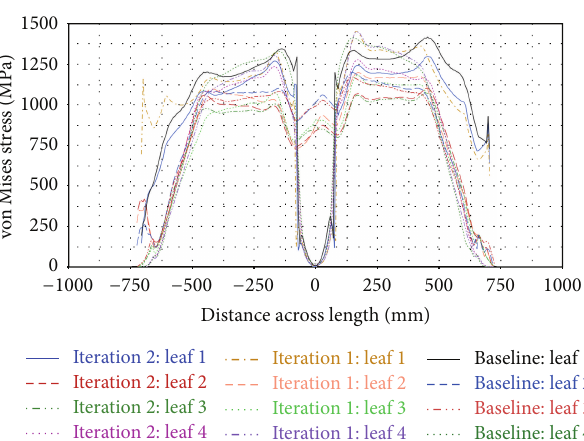
Figure 14: von Mises stress across length plot of roll load